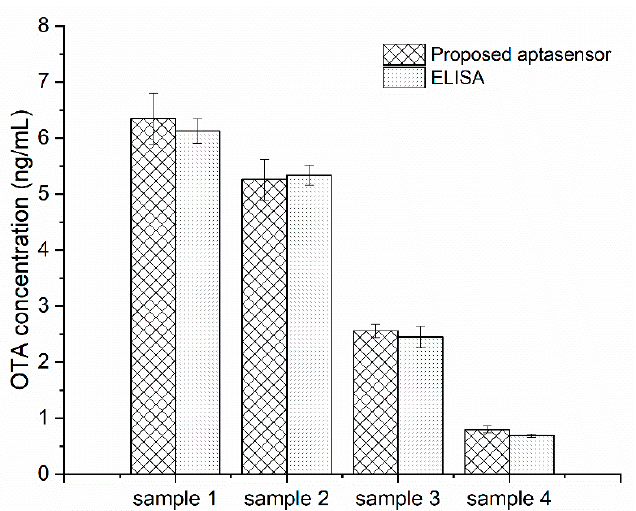
Figure 7. Comparison of the proposed aptasensor and ELISA for OTA detection in oat (sample 1, and 2) and rice (sample 3, and 4) samples.